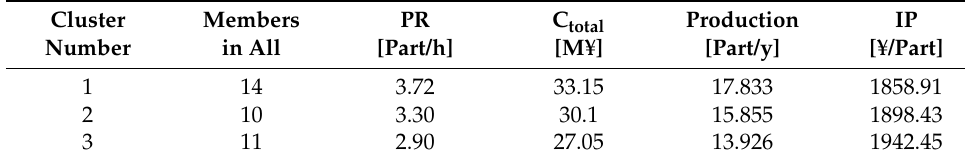
Table A10. Cluster analysis of the new approach (Case D).